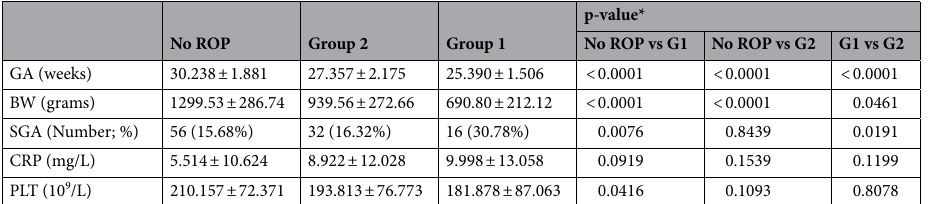
No ROP Group 2 Group